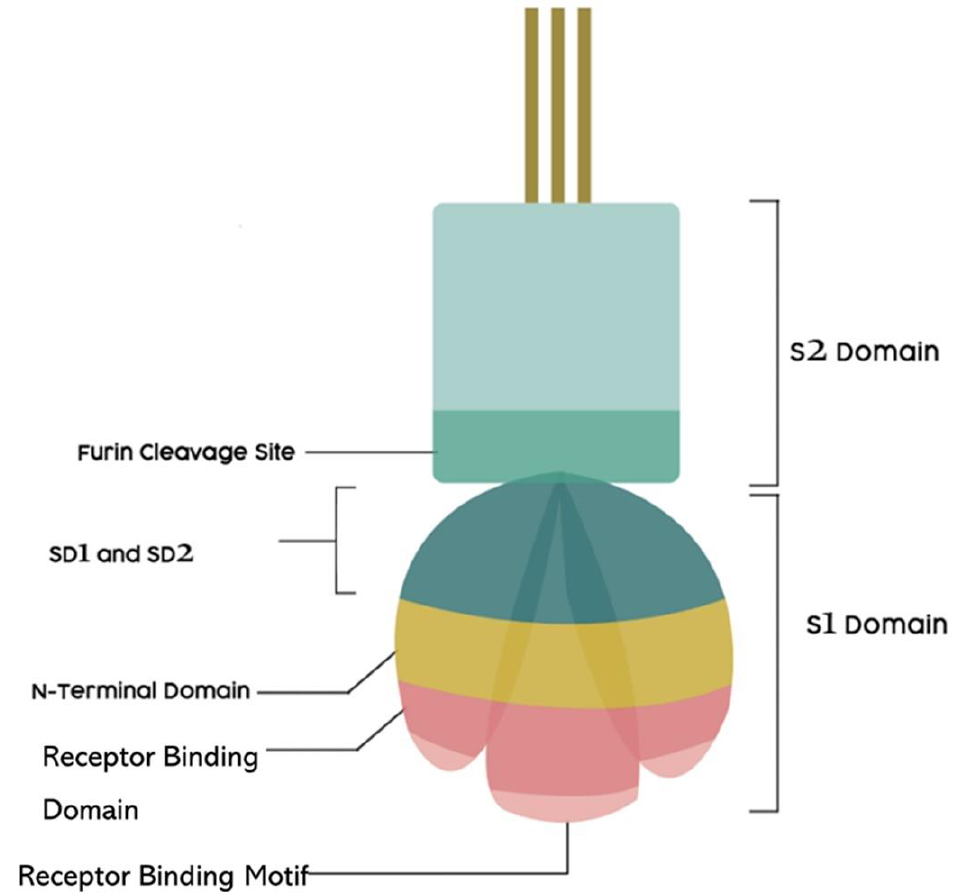
Figure 1. Details of domains in the structure of SARS-CoV-2 spike protein. The spike protein is divided into two main segments: S1 domain and S2 domain. The S1 domain essentially caps the S2 domain and is cleaved off during entry through the ACE2 receptor.